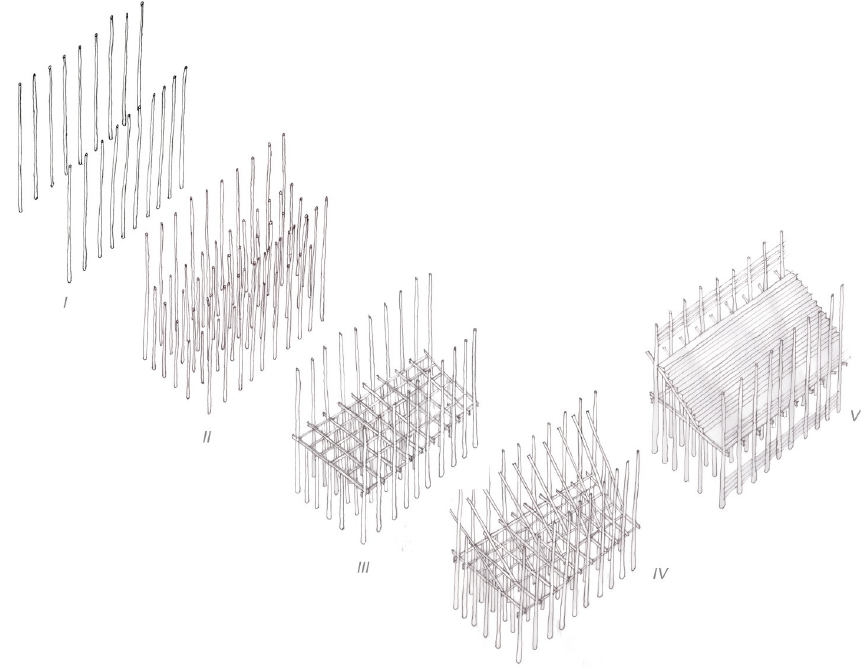
Figure 10. Representation of the assembly sequence of the modular unit ( palco ) of the Corraleja. Source: Massimo Leserri, 2017